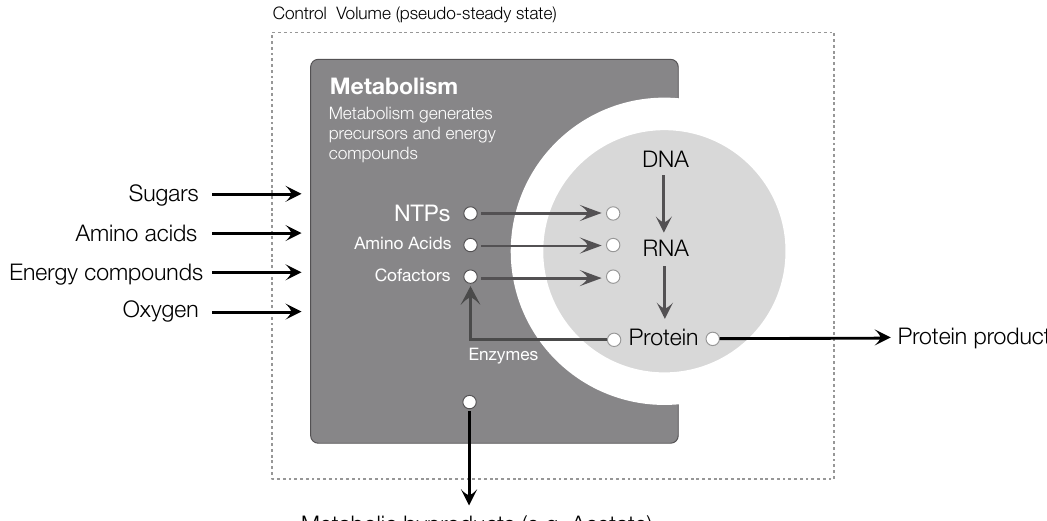
Figure 3. Schematic of the integration of transcription and translation processes with metabolism. Transcription and translation processes demand macromolecular precursors (e.g., NTPs, amino acids, and cofactors) from metabolism for gene expression. The integrated framework is represented as a stoichiometric matrix of metabolites participating in certain reactions, along with a description of the metabolic demands for protein expression. The metabolic flux is estimated subject to constraints, a pseudo-steady-state assumption, and an objective